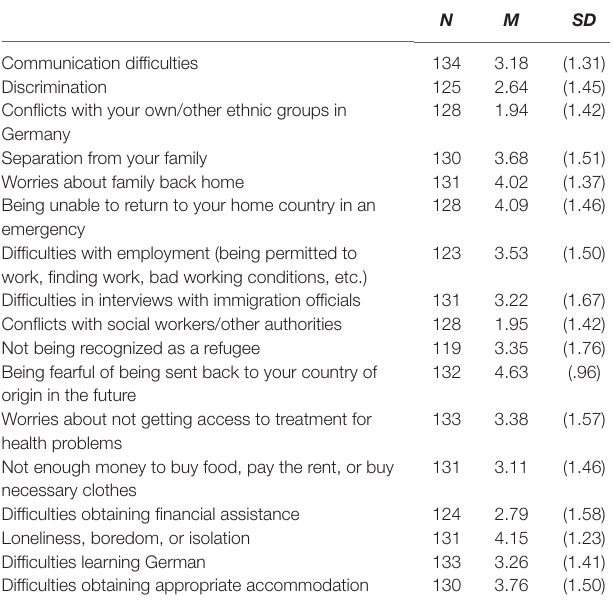
TABLE 6 | Prevalence of post-migration living difficulties (PMLDC) before treatment.